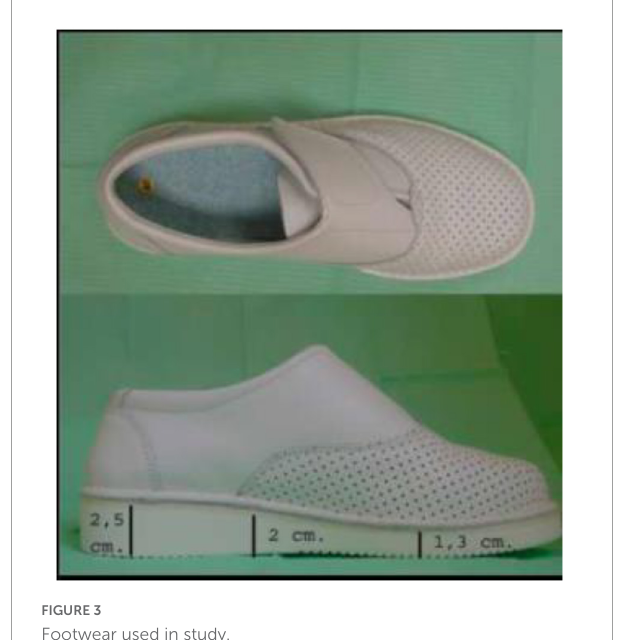
FIGURE3 Footwear used in